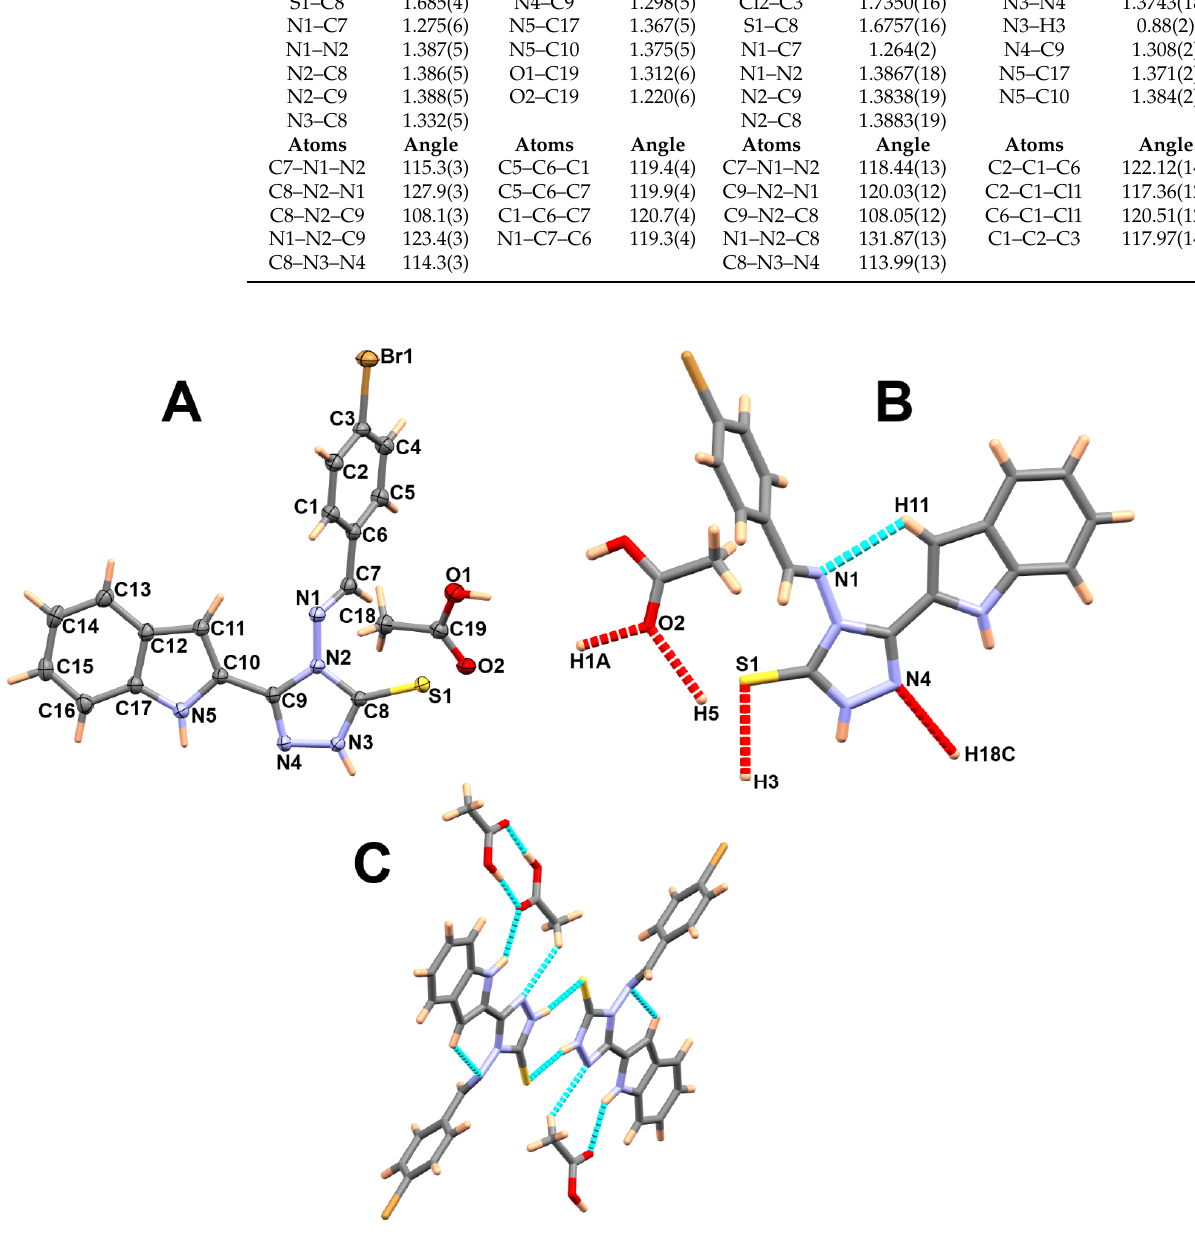
Figure 1. Structure of the asymmetric unit with atomic numbering and thermal ellipsoids drawn at 30% probability ( A ), most important hydrogen bond contacts ( B ) and hydrogen bonding interactions ( C ) in 3 .